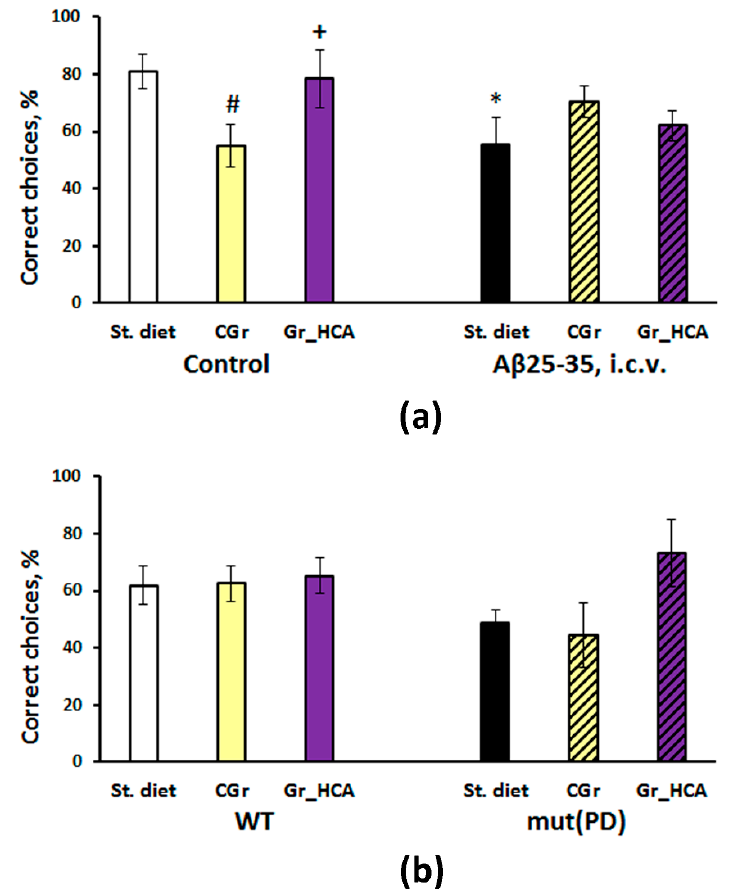
Figure 2. Effects of the type of diet and A β 25-35 administration (Alzheimer’s disease (AD) model) ( a ) or of the type of diet and overexpression of α -synuclein (genetic PD model) ( b ) on the working memory in mice evaluated in the T-maze test. Data are presented as the mean ± S.E.M. of the values obtained in an independent group of animals ( n = 5–11 per group). Statistically significant differences: * p < 0.05 vs. a respective control group (in the experiment with AD model); # p < 0.05 vs. a respective group given the standard diet (St. diet); + p < 0.05 vs. a respective group given the control grain diet (CGr).